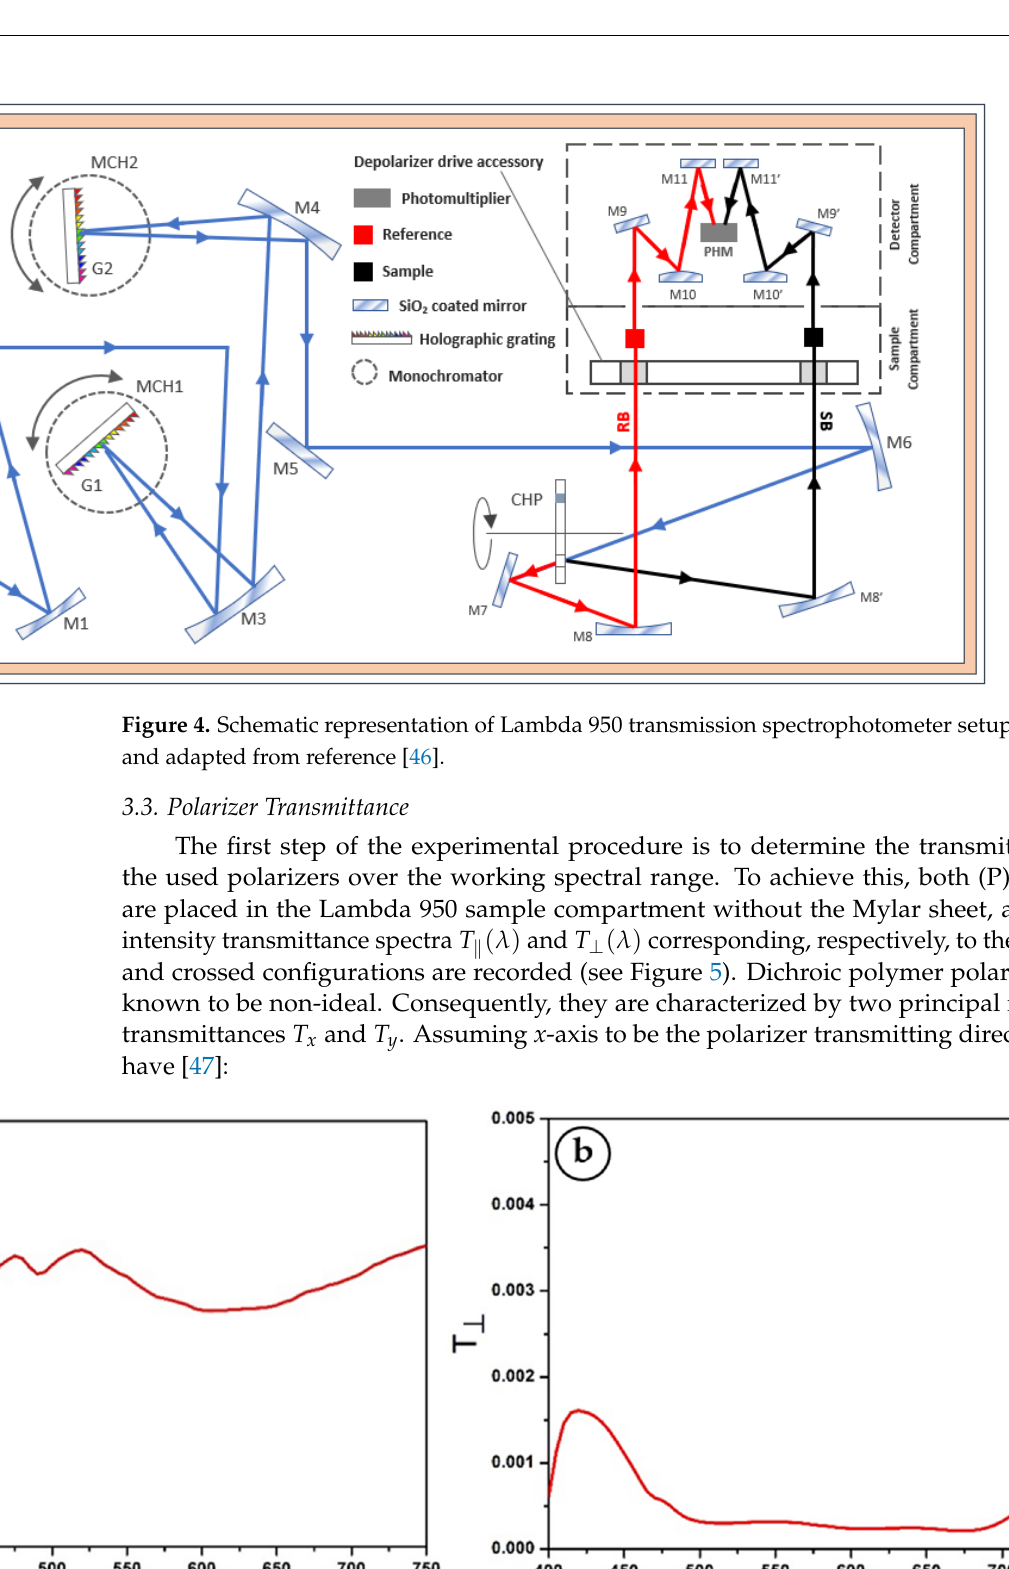
Figure 5. Polarizer and analyzer transmittance spectra for both parallel ( a ) and crossed ( b ) configu- rations.